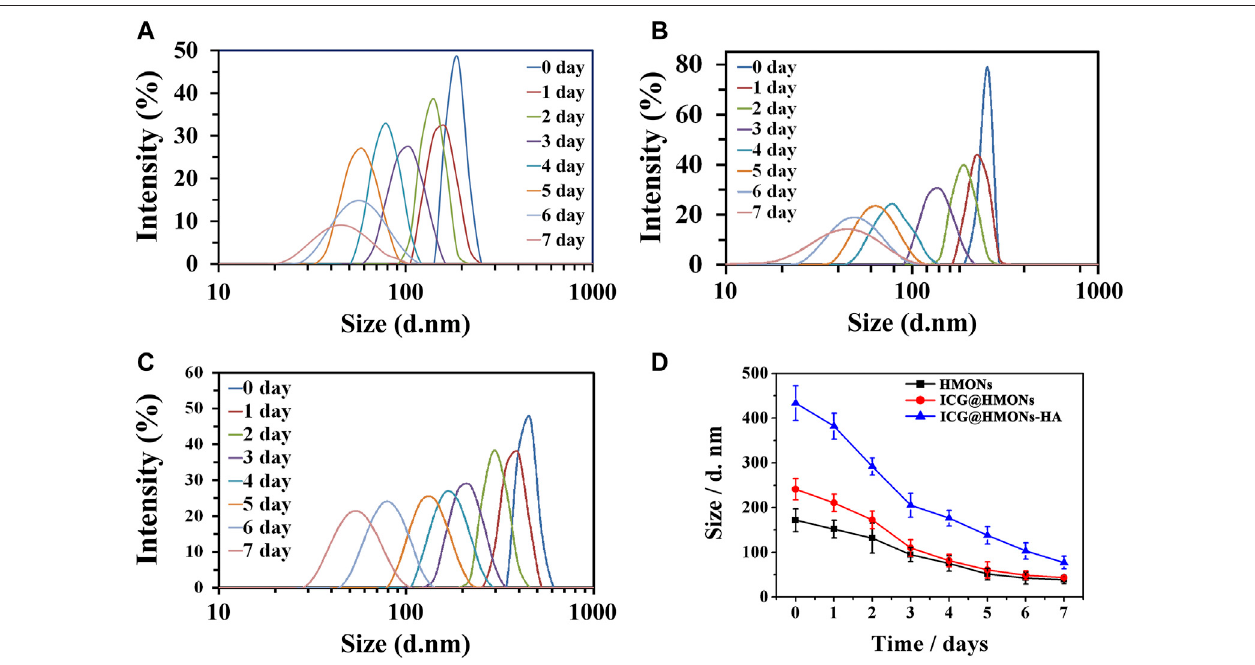
FIGURE 2 | Change of hydrodynamic diameter of HMONs-NH 2 (A) , ICG@HMONs (B) , and ICG@HMONs-HA (C) in 7 days determined by DLS. (D) Summary of the change of hydrodynamic diameter for the three nanomaterials. Each experiment had been repeated three times. Error bars indicate ± s .d.